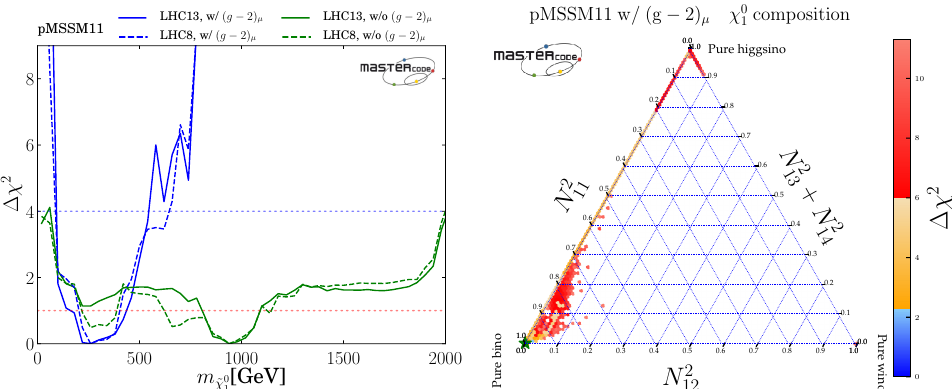
Figure 1. Upper plot: one-dimensional profile likelihood functions for the ˜ χ 0 with (blue) and without the ( g 2 ) µ constraint (green) and with (solid) and without (dashed) applying − the constraints from LHC Run II. Lower plot: triangular presentations of the composition of the ˜ χ 0 the fit with LHC 13-TeV and with the ( g 2 ) µ constraint. The best-fit point is marked with a green − star. Taken from [41].